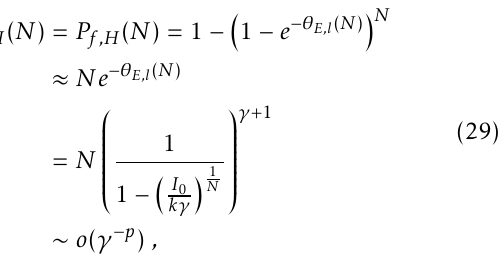
, by setting P md,H ( N ) = I 0 k